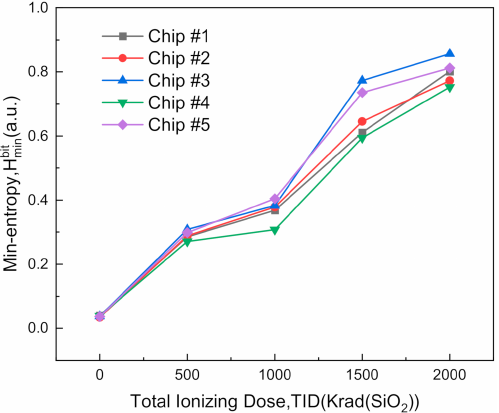
Figure 4. Min-entropy ( H bit